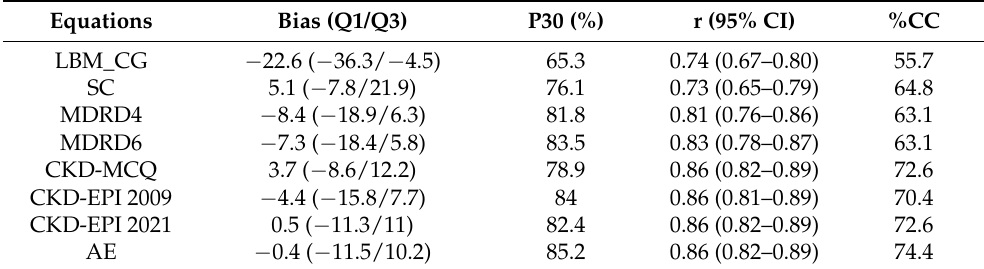
Table 2. Performance of the different equations to estimate the mGFR in the IVS ( n = 189).